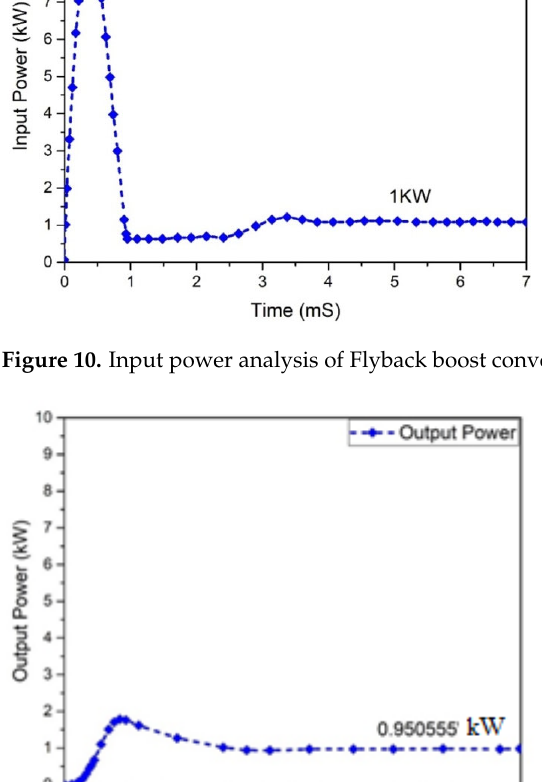
Figure 11. Output power of Flyback boost converter.